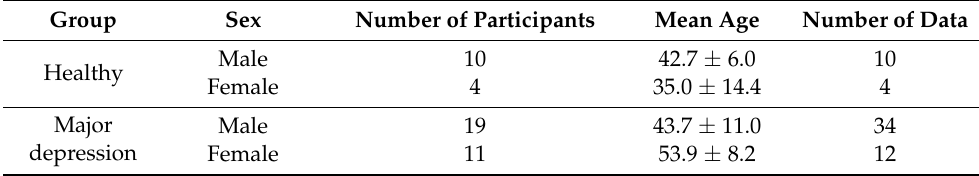
Table 3. Experimental participant information for algorithm verification. Group